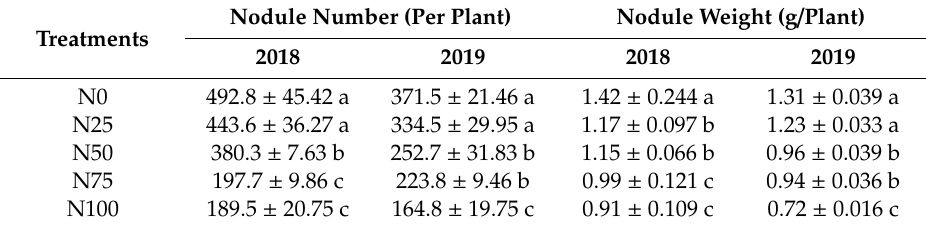
Table 1. Change in the number and weight of soybean root nodules in experiment I. Nodule Number (Per Plant) Nodule Weight (g / Treatments